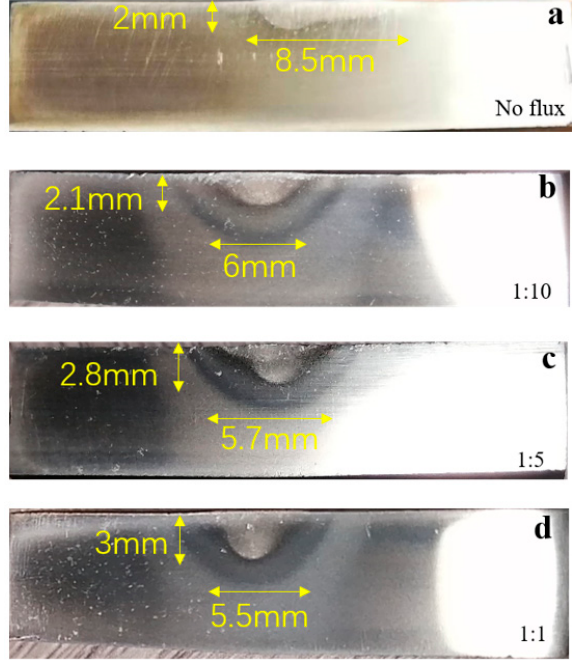
Figure 4. Weld bead geometry images of welded joints without fluxes, and with different concen- trations of Fe 2 O 3 nanowire fluxes (( a ): no flux, ( b ): 1:10, ( c ): 1:5 and ( d ): 1:1) welding under speed of 120 mm/min.